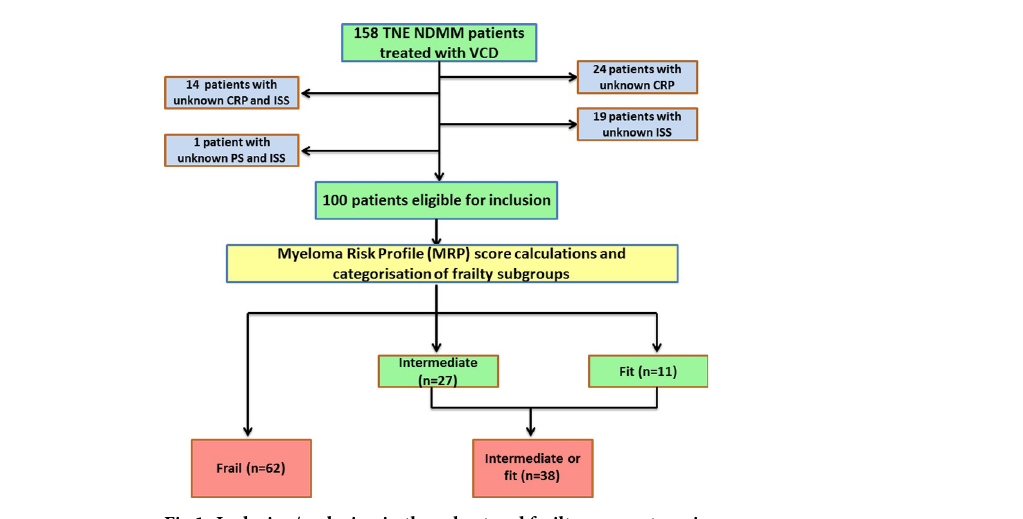
Fig 1. Inclusion/exclusion in the cohort and frailty score